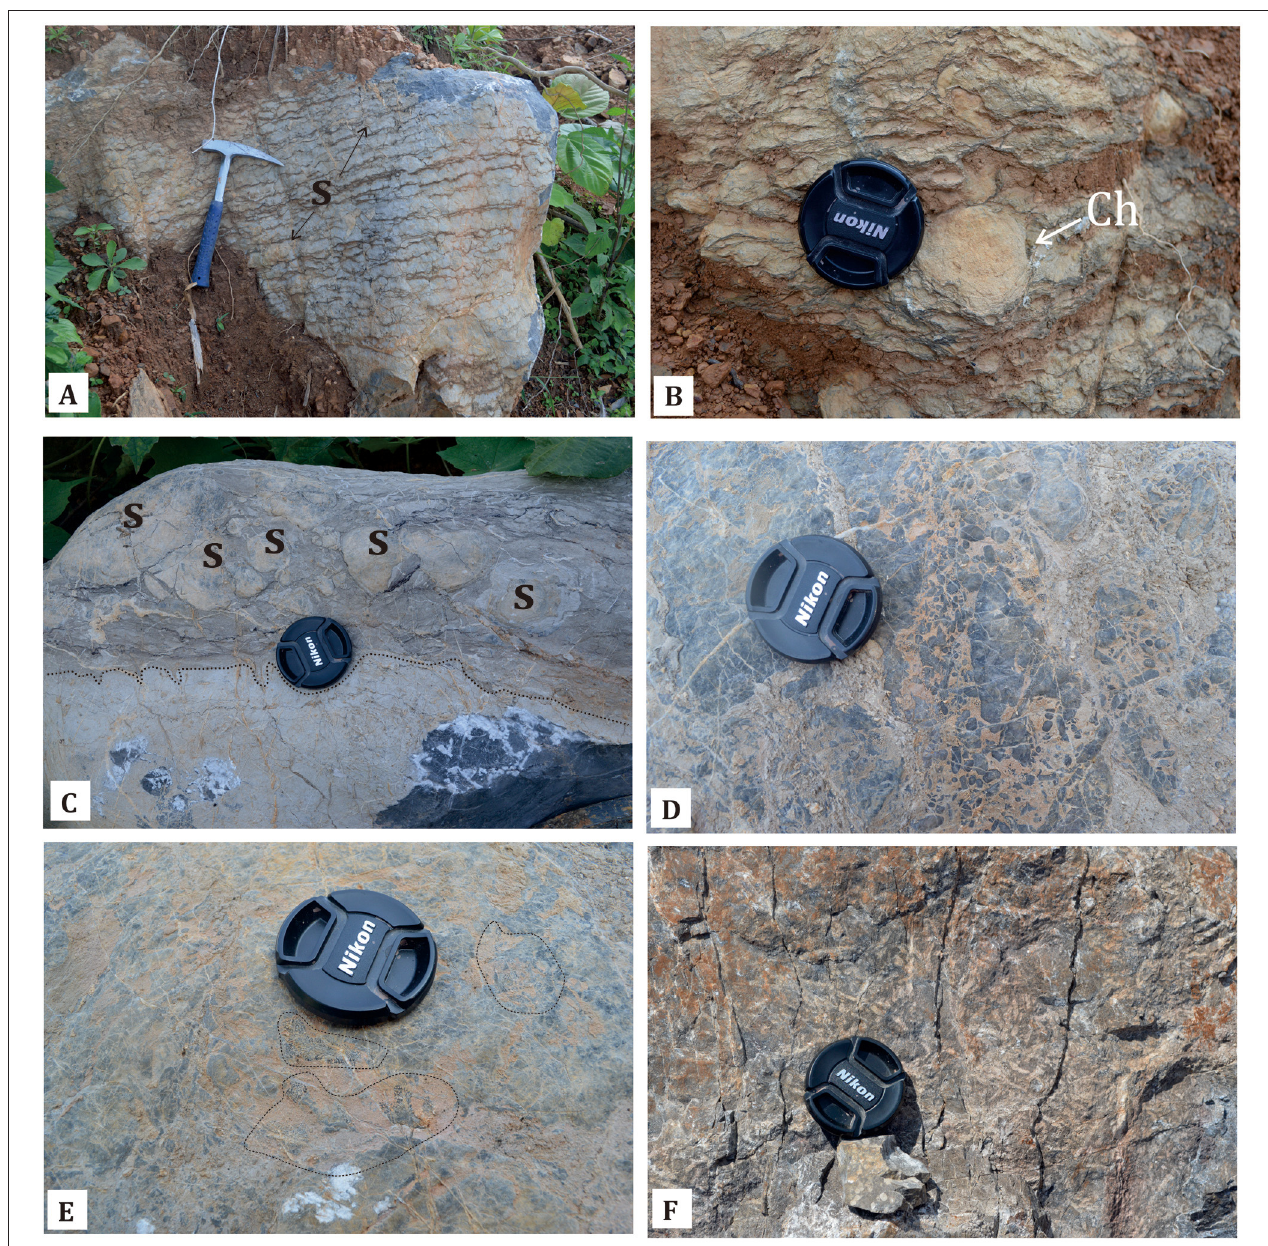
FIGURE 10 | Facies variation of limestone from Unit A of Figure 9 . (A) Stromatolitic limestone (algal laminite) with small domal stromatoporoid. (B) Stromatolitic limestone with Chaetetes (Ch) (sponge) in growth position. (C) Micritic limestone with truncation on top and overlain by limestone breccia (intraformational breccia). The sharp truncation suggests aerial exposure and karstification. Clasts of limestone breccia consist of large domal fragments of stromatoporoid (S), skeletal debris, and lithoclasts. (D,E) limestone breccia with abundant clasts of tabulate corals (? Thamnopora ). This evidence suggests the existence of a stromatoporoid-coral reef prior to the collapse of the carbonate platform. (F) Reef limestone (foreground of Figure 9C ) showing abundant Stachyodes